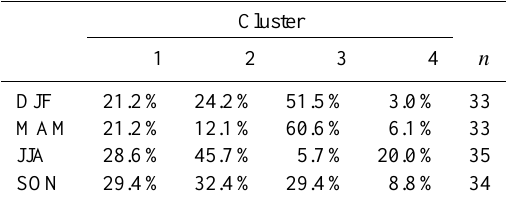
Table 6. Seasonal frequencies (in percentage) of the backward tra- jectory clusters calculated from single events at OH station. The right column indicates the number ( n ) of single events recorded in each season.